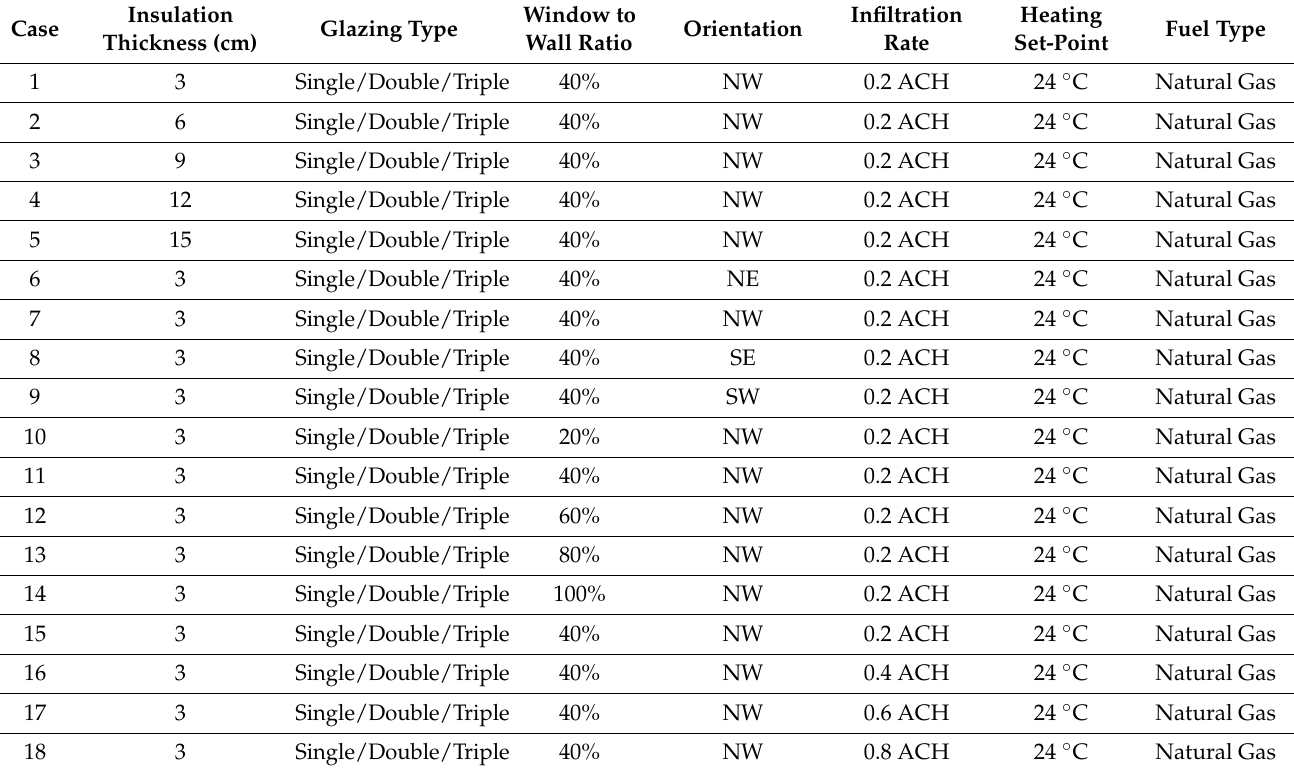
Figure 4. Mean, minimum, and maximum monthly temperatures for Hakkari .